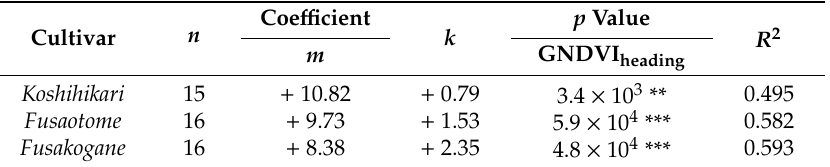
Table 2. The results of simple linear regression analysis for rice grain protein content estimation. n = number of samples, m = coe ffi cient, k = intercept, GNDVI heading = Yubaflex-based green normalized di ff erence vegetation index at the heading stage.